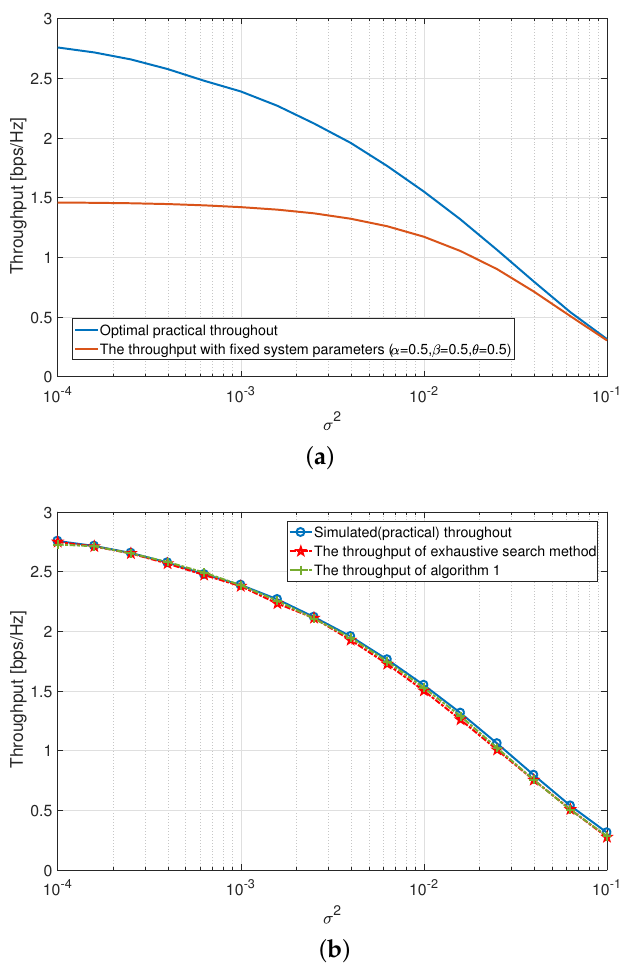
Figure 6. Optimal throughput as a function of noise power. ( a ) Optimal throughput vs. throughput with fixed system parameters. ( b ) The throughput obtained by different